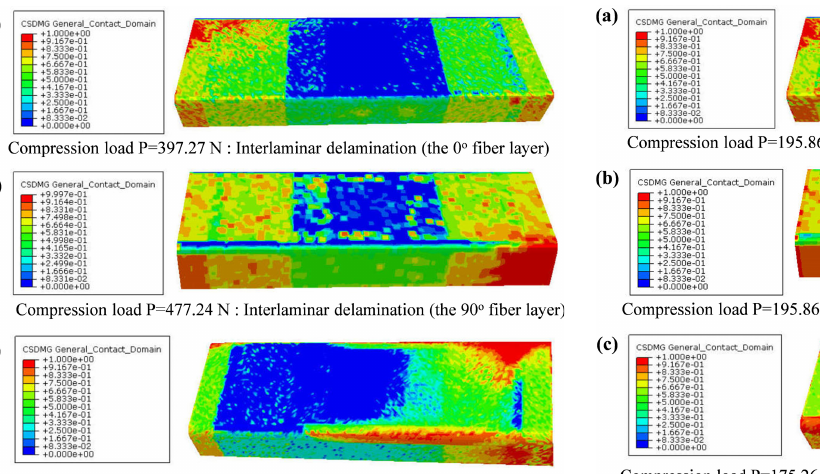
Figure 14: Initial interlaminar delamination failure area distribution of compression columns: (a) DCYG-A: 0 ∘ fiber layer, (b) DCYG-A: 90 ∘ fiber layer, and (c) DCYG-B: 45 ∘ fiber layer.